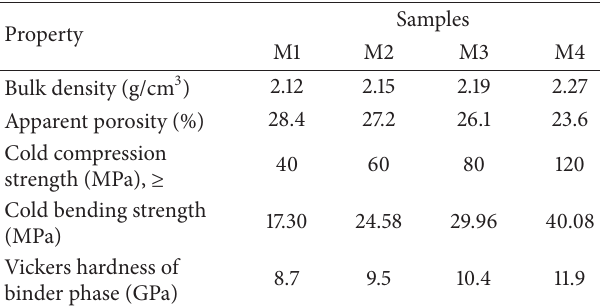
Table 2: Properties of mullite-SiC composite refractories prepared by nitriding reactive.